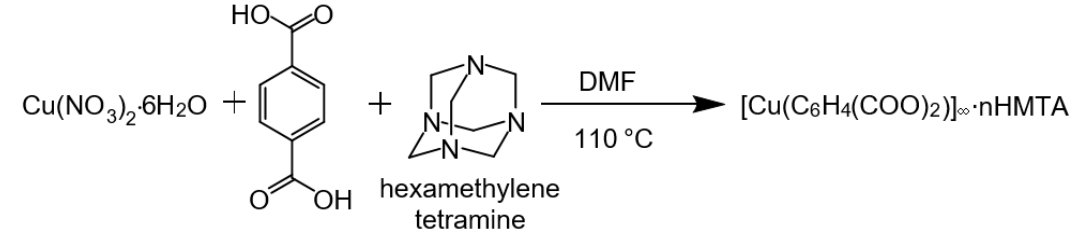
Figure 1. Reaction scheme for Cu-BDC ⊃ HMTA synthesis.